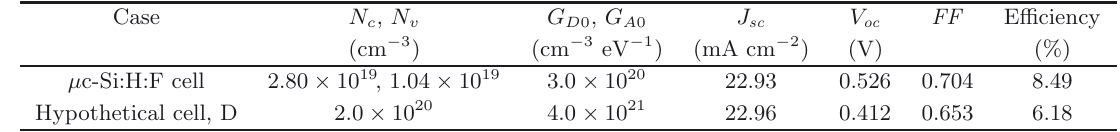
Table 4. The solar cell output parameters of two μ c-Si:H cells having exactly the same parameters as the lowest F c μ c-Si:H cell A , except the band gap of the intrinsic material.